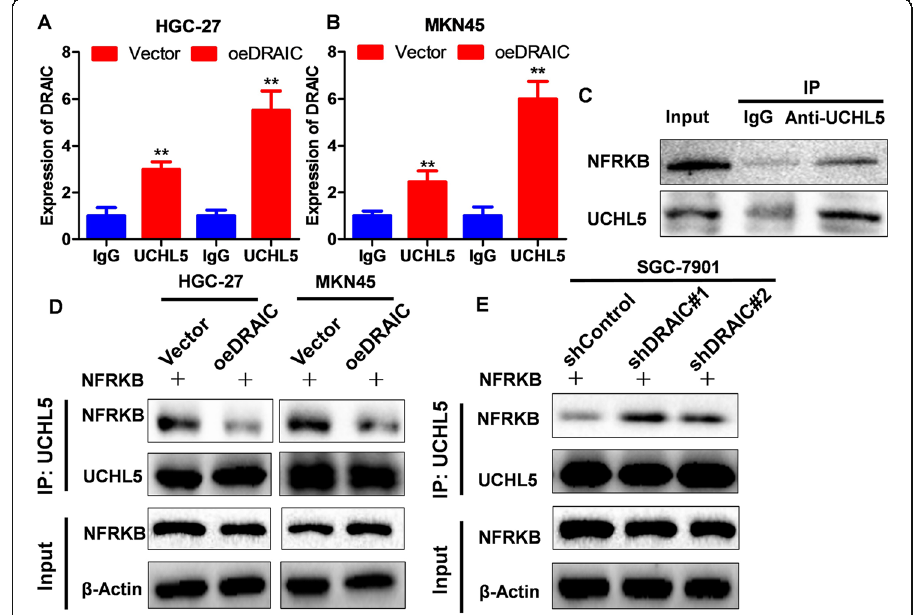
Fig. 3 The combinations of DRAIC and UCHL5 and the effects of DRAIC on the binding of NFRKB and UCHL5. a. The combination of DRAIC and UCHL5 in HGC-27 Vector and oeDRAIC cells. b. The combination of DRAIC and UCHL5 in MKN45 Vector and oeDRAIC cells. c. The combination of UCHL5 and NFRKB in HGC-27 cell. d. The combination strength of UCHL5 and NFRKB in HGC-27/MKN45 Vector and oeDRAIC cells. e. The combination strength of UCHL5 and NFRKB in SGC-7901 shControl and shDRAIC cells. Quantitative data are presented as means ± SD. ** P < 0.01 compared with the IgG group